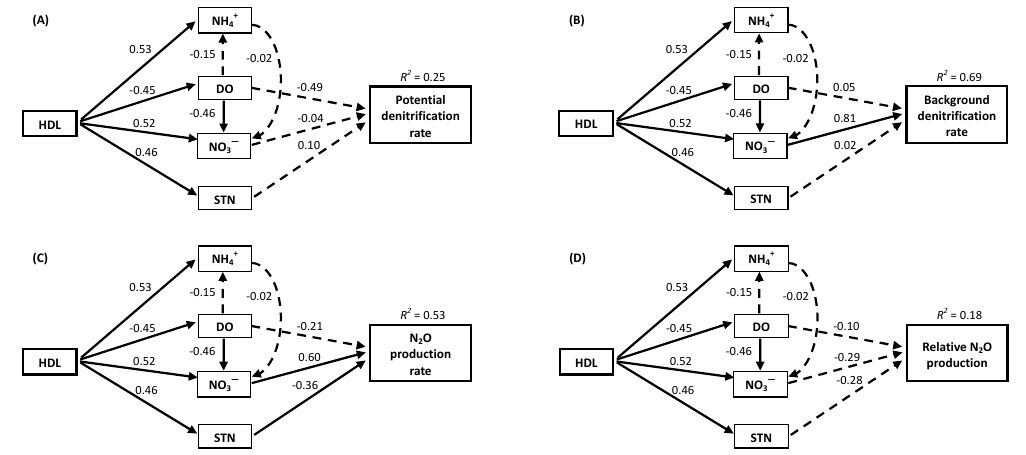
Figure 4. Structural equation models depicting the indirect effects of human-dominated land uses (HDL) in watersheds on the sediment potential denitrification rate (a) , background denitrification rate (b) , N 2 O production rate (c) and relative N 2 O production (d) of the Yangtze lakes ( N = 20). Solid lines indicate significant ( P <0.05) positive or negative effects, and dashed lines indicate insignificant positive or negative effects. Numbers adjacent to the lines are standardised path